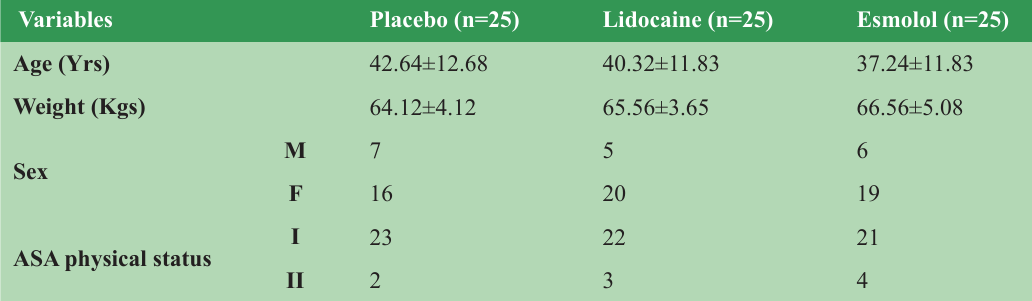
Table 1: Demography and ASA status of the patients in placebo, lidocaine and esmolol group Variables Placebo (n=25) Lidocaine (n=25)